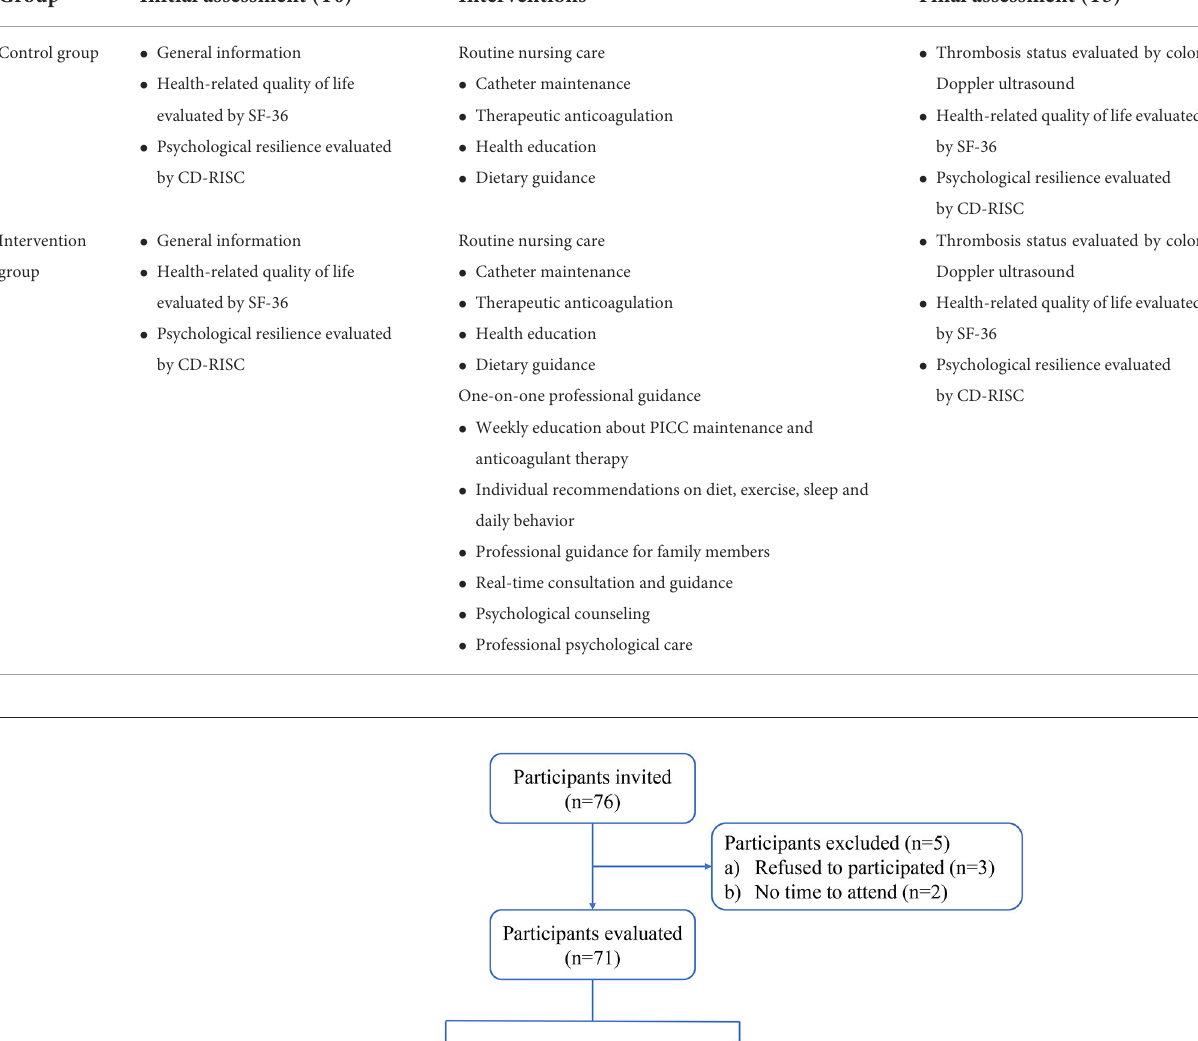
TABLE 1 The procedures for the control and intervention groups. Group